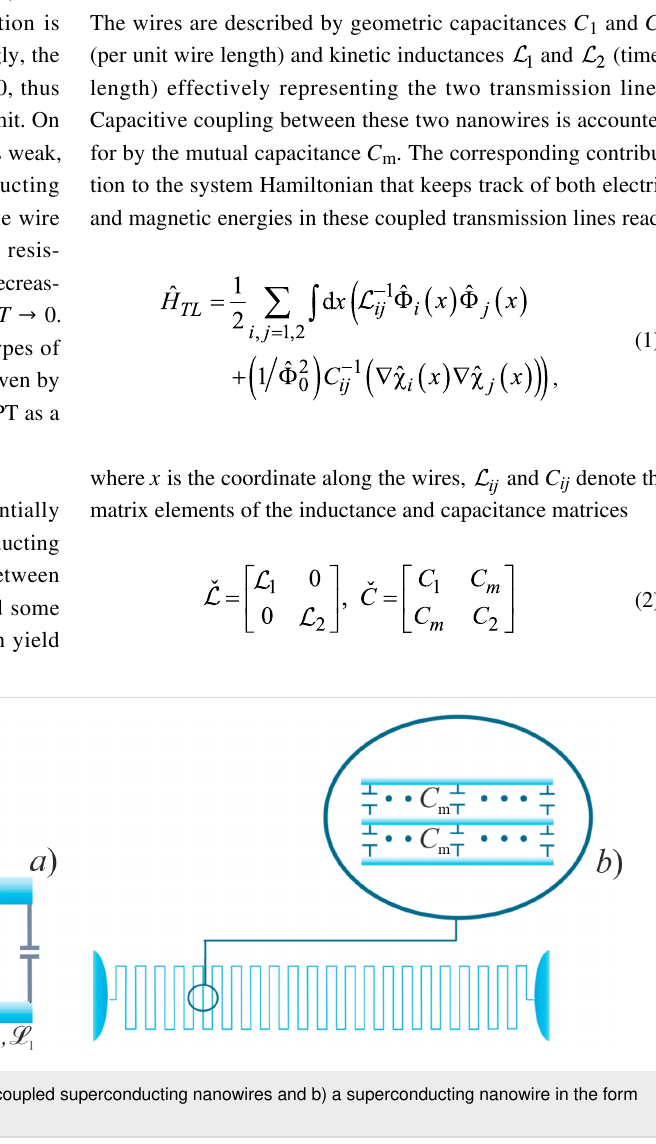
process of quantum tunneling of magnetic flux quanta